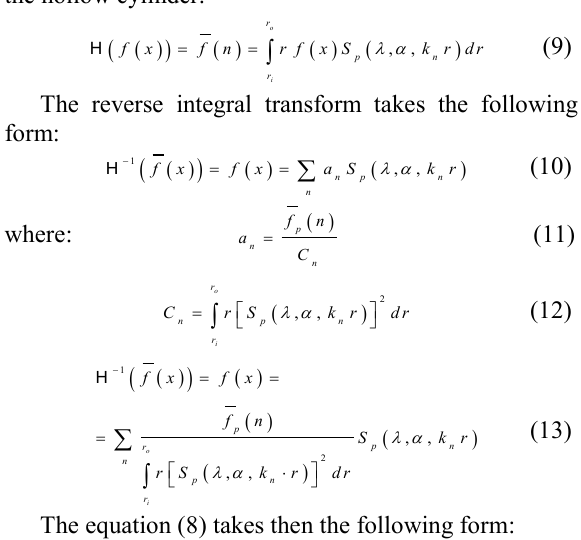
Fig. 2 . The heat flux distribution on the lower surface of the hollow